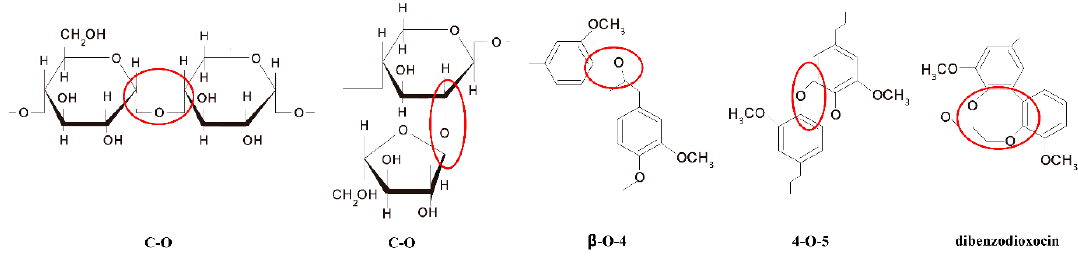
Figure 5. C–O bonds in polysaccharide and β -O-4, 4-O-5, and dibenzodioxocin bonds in lignin.